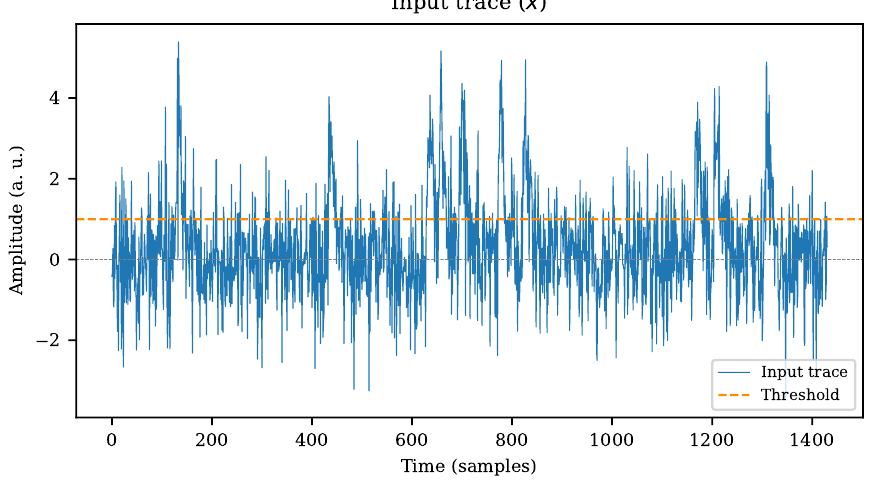
Figure 3. Input signal x passed through a simple cross-level trigger system. A constant threshold value is